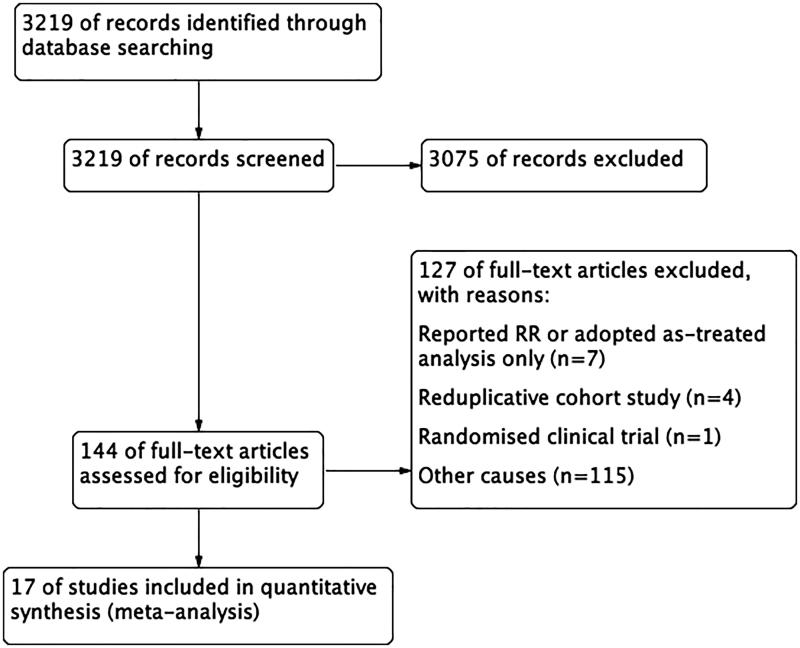
Study flow diagram.